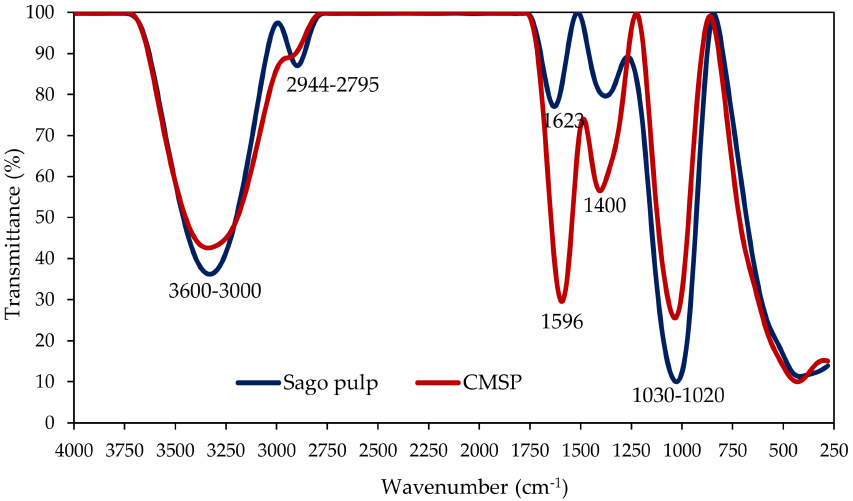
Figure 1. Fourier transform infrared (FTIR) spectra pattern of pre-treated sago pulp and carboxymethyl sago pulp